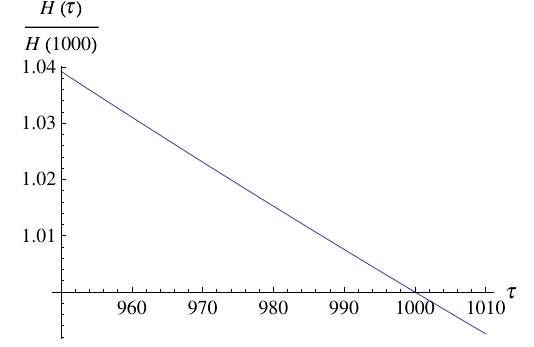
Fig. 7 The dependence H (τ) for α = 10 − 105 and E 0 We include influence of the radiation for the evolution of the Hubble function. Note that dark energy has a negligible influence on the evo- lution of the Hubble function. The rescaled time τ is given in units of [ 1 . 3 × 10 − 40 s ]